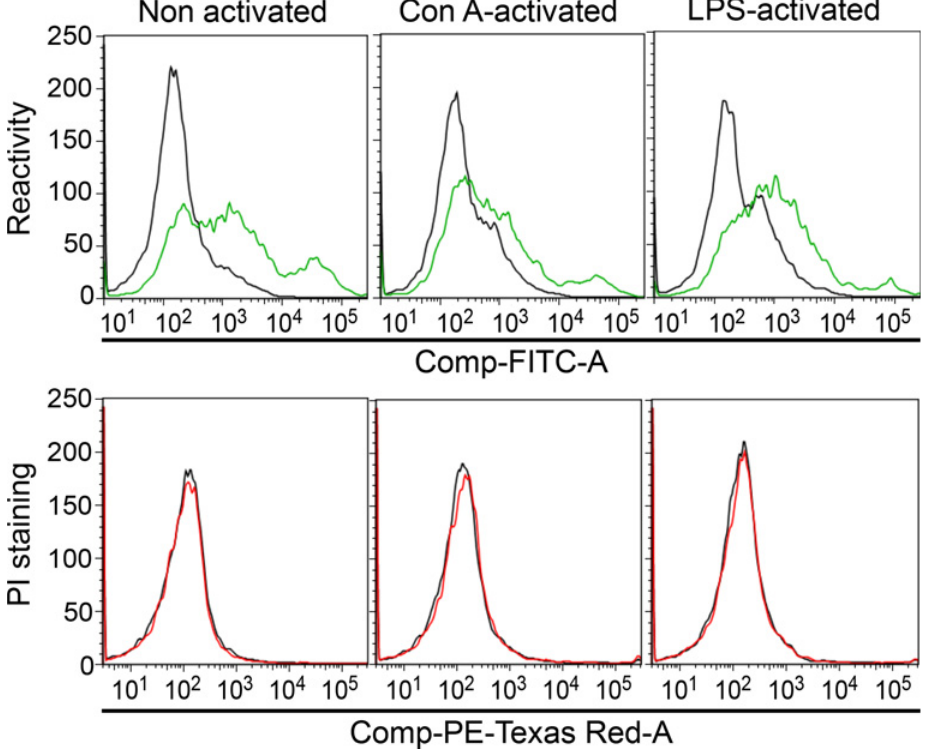
Fig 2. Lack of cytotoxicity of mAb 4713 on lymphocytes from healthy donors. Freshly isolated, or Concanavalin (Con) A- or LPS-activated (12 h), peripheral blood lymphocytes were incubated with mAb 4713 for 2 h, then with Alexa 488-conjugated anti-mouse IgG (green) or propidium iodide (red). Negative controls are shown by black lines.